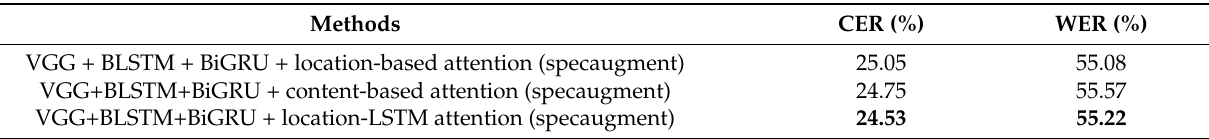
Table 5. Results of the ablation study of improved attention. Our experimental results are highlighted in bold.